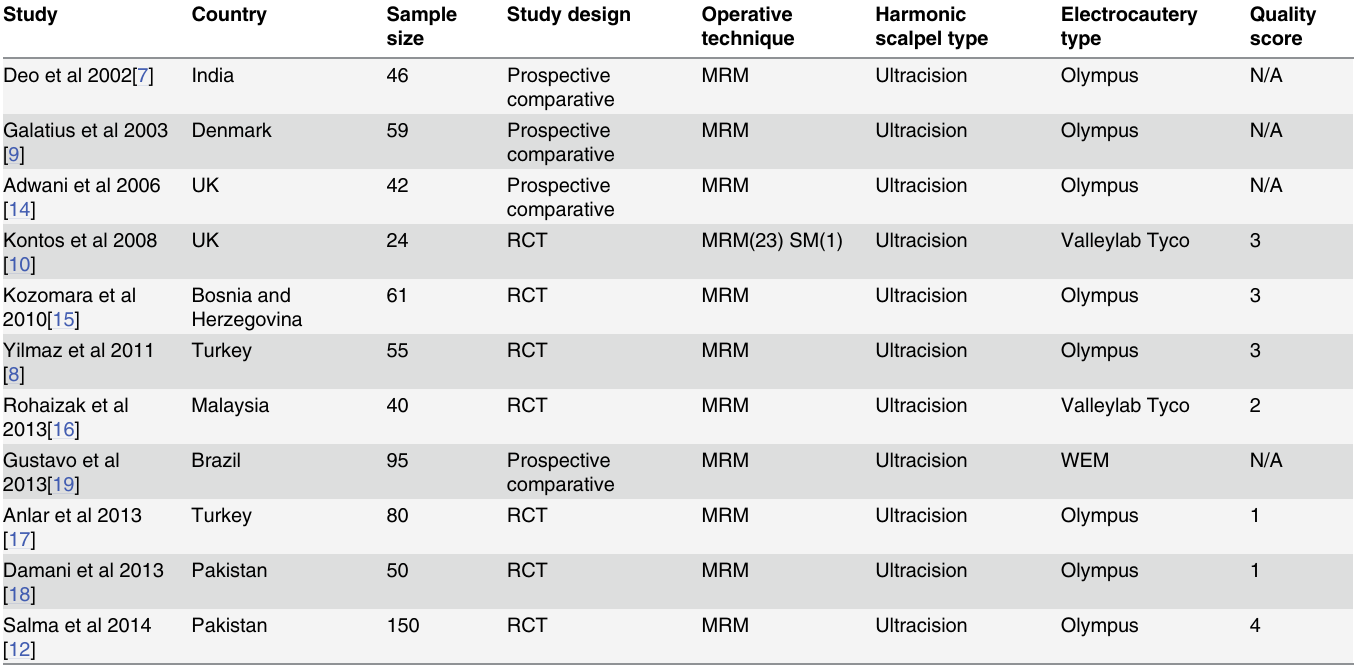
Table 1. Characteristics of eligible studies included in this